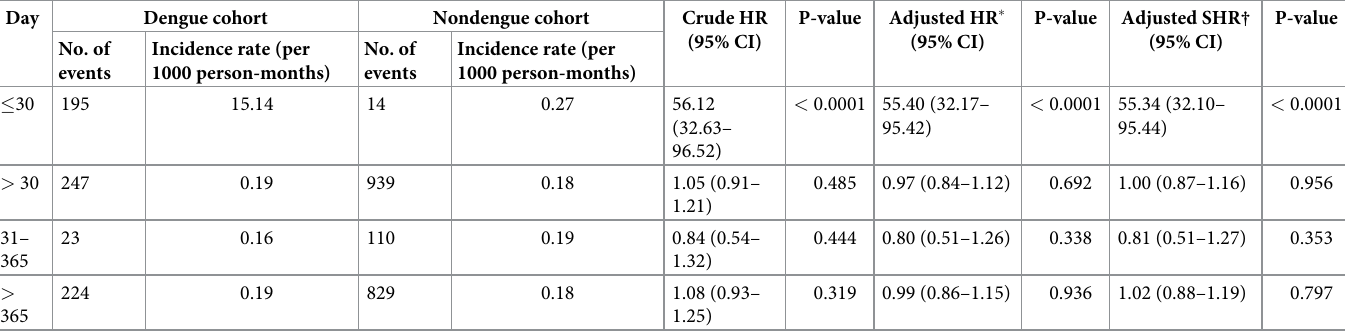
Table 2. Comparison of the incidence of nonvariceal upper GI